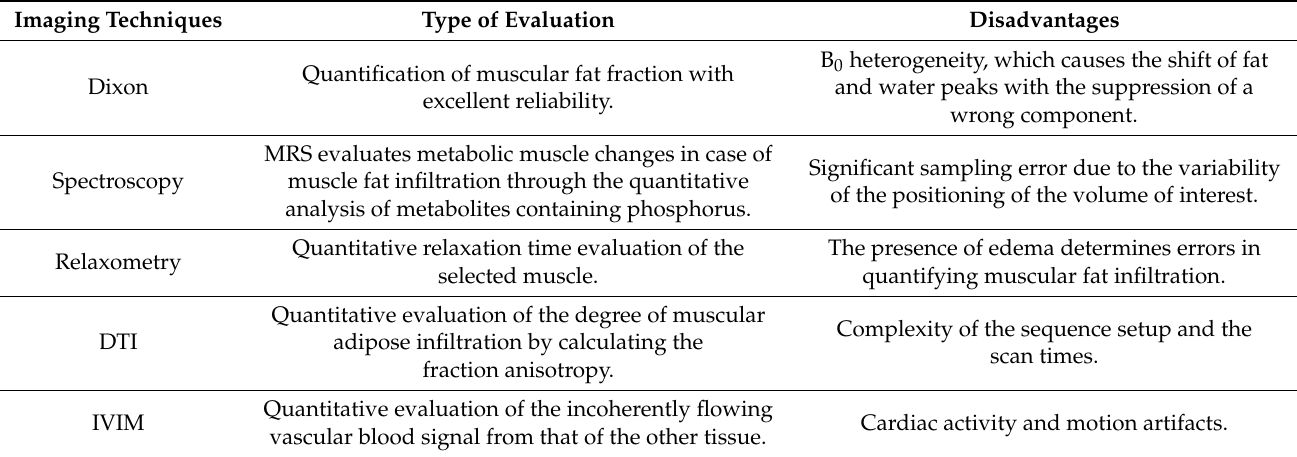
Table 1. Summary of different MR imaging